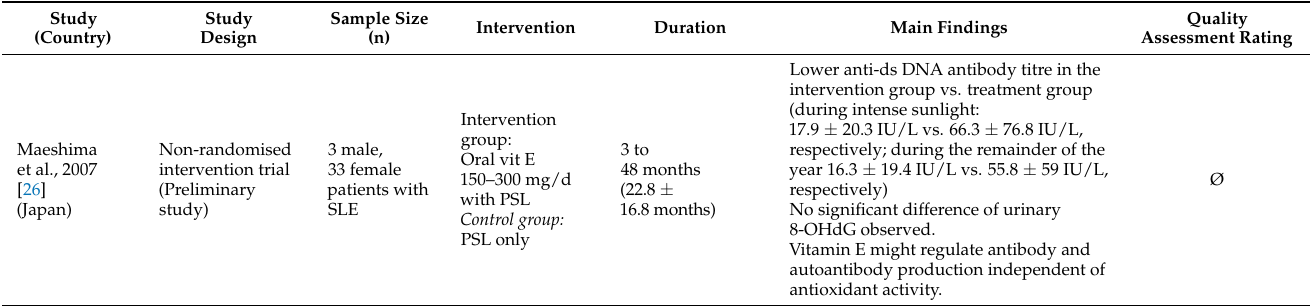
Table 3. Characteristics of included studies on vitamin E supplementation interventions.